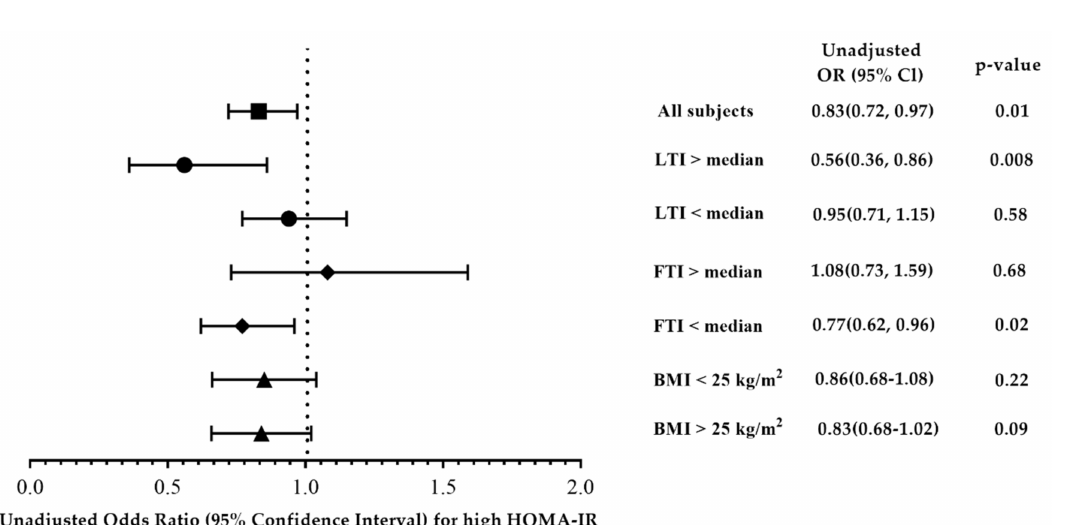
Figure 1. Adjusted odds ratios (ORs) of Log-formed A. muciniphila and high HOMA-IR (>median) in T2D patients stratified by lean tissue index (LTI), fat tissue index (FTI), and body mass index (BMI) cut at 25 kg/m 2 . Ratios were adjusted for age, sex, BMI, cholesterol, log-formed triglyceride, and glycated